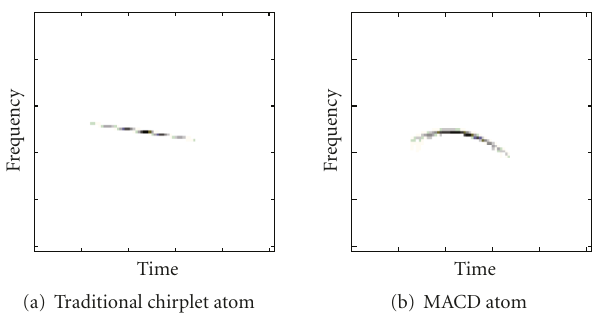
Figure 1: Time frequency distributions of the